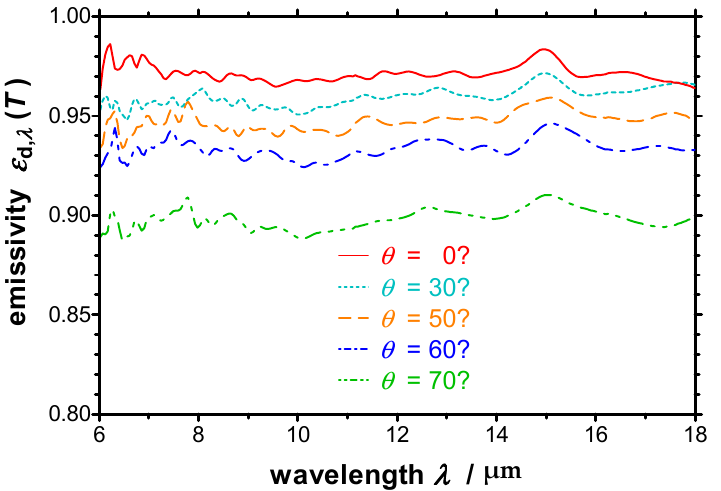
Figure 12. Spectral directional emissivity of a Nextel-Velvet-Coating 811-21 measured with the EMMA at a temperature of T = 372 K and different emission angles. The emissivity decreases with increasing emission angle as expected for an electrically non-conducting material.